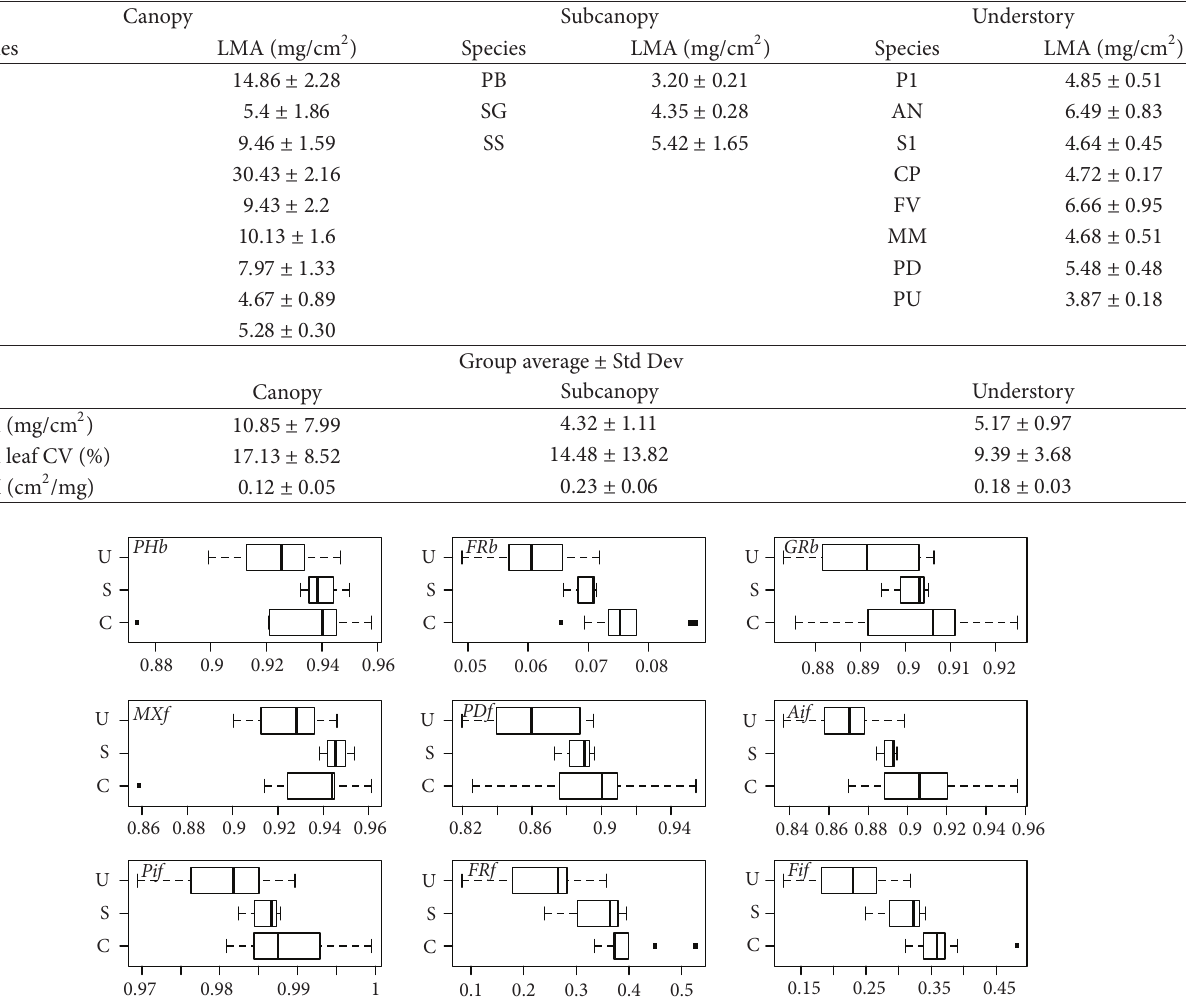
T 5: LMA by species, group average for LMA and EAM, and coefficient of variation (CV, in